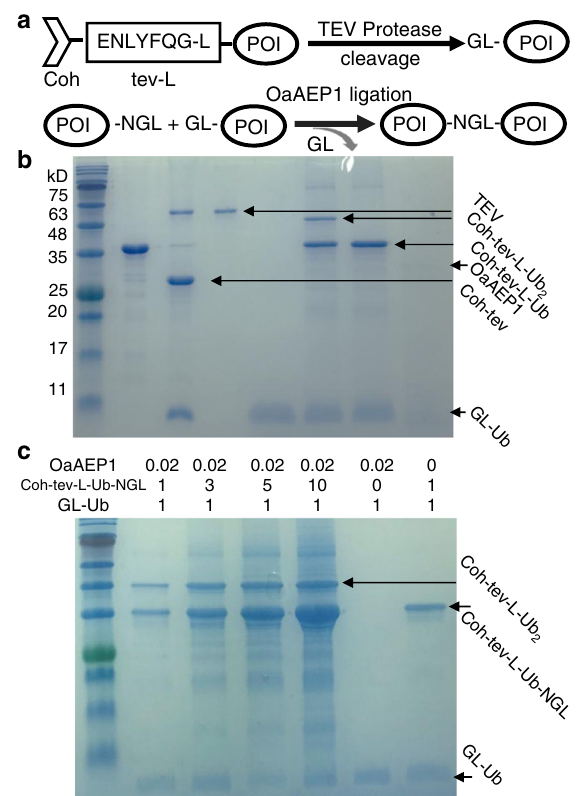
Fig. 5 The high-ef fi ciency construction of a protein dimer using OaAEP1 and TEV protease. a The schematic shows a removable N-terminal TEV site functions as a protective unit and its cleavage leads to a stepwise ligation using OaAEP1. b SDS-PAGE gel results showed the cleaved GL-Ub from Coh-tev-L-Ub reacted well with Coh-tev-L-Ub-NGL forming a Ub dimer as Coh-tev-L-(Ub) 2 . Lanes 1 – 4 show Coh-tev-L-Ub, the protein mixture after TEV cleavage, pure TEV protease (sfGFP-TEV) and puri fi ed cleaved GL-Ub. Lanes 5 – 7 show the ligation product mixture using the cleaved GL-Ub and Coh-tev-L-Ub-NGL for ligation, the reactant mixture without OaAEP1 is used as a control and pure OaAEP1. c The OaAEP1 ligation ef fi ciency is proportional to the ratio between the two reactants, Coh-tev-L-Ub-NGL and GL-Ub. The ef fi ciency increases from 20% when the ratio is 1 to 1, to 40% when the ratio is 3 to 1, to 50% when the ratio is 5 to 1, and reached